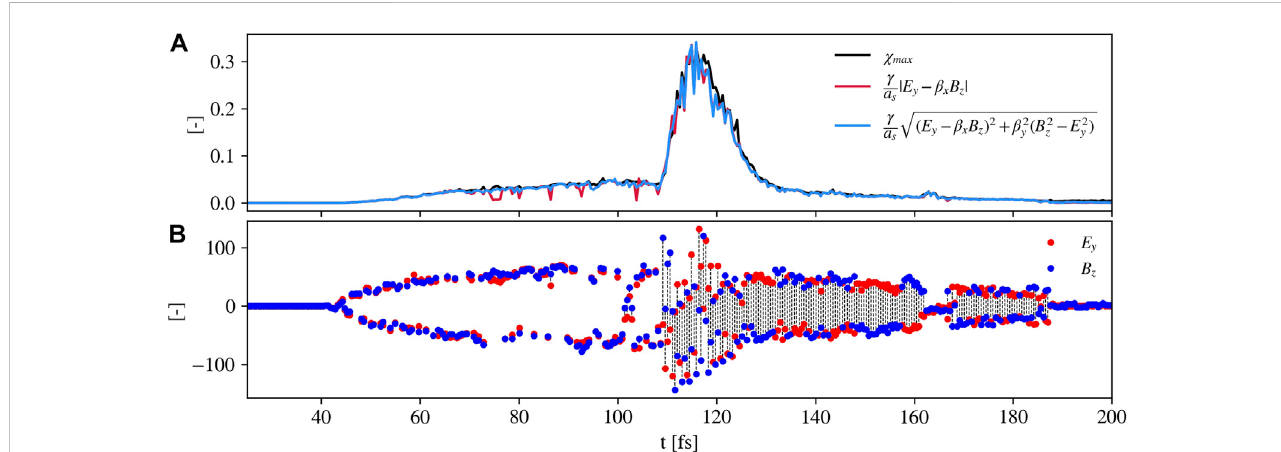
FIGURE 3 In (A) , maximum values of χ obtained during the simulation: in black, the simulation values; in red, the values computed with formula 2 considering the macroelectronswiththemaximum χ ,andinbluethevaluescalculatedinthesamewaybutwithanadditionalcorrection.In (B) ,theelectric fi eldnormalizedby c / e inthe y direction(red dots)and themagnetic fi eld normalized by m e ω m e ω 0 at each timestep of the simulation diagnostic. The two fi eld values for each macroelectron are connected with a dashed black